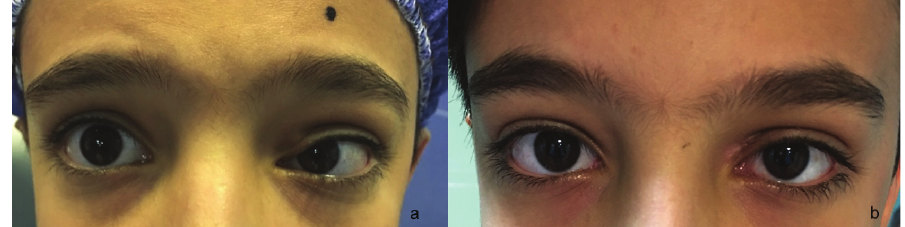
Figure 1. The appearance of the patient in the (a) initial visit, showing fullness of superomedial left upper lid. (b) Face photograph six months after surgery. Complete resolution of swelling. Patient is orthotropic after tumor resection from medial rectus muscle.